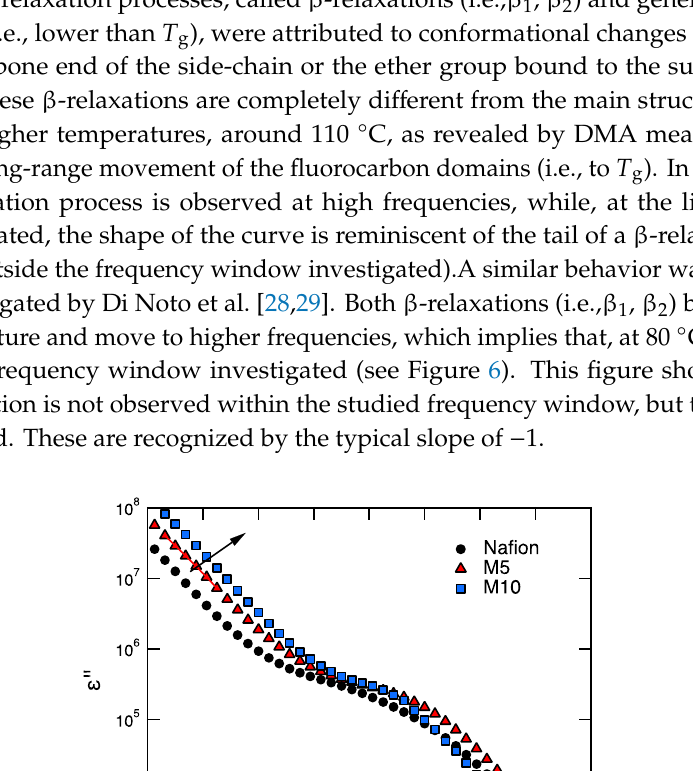
Figure 7. Conductivity ( σ ’) spectra as a function of frequency for Nafion ( a ), M5 ( b ), and M10 ( c ), during heating and cooling.